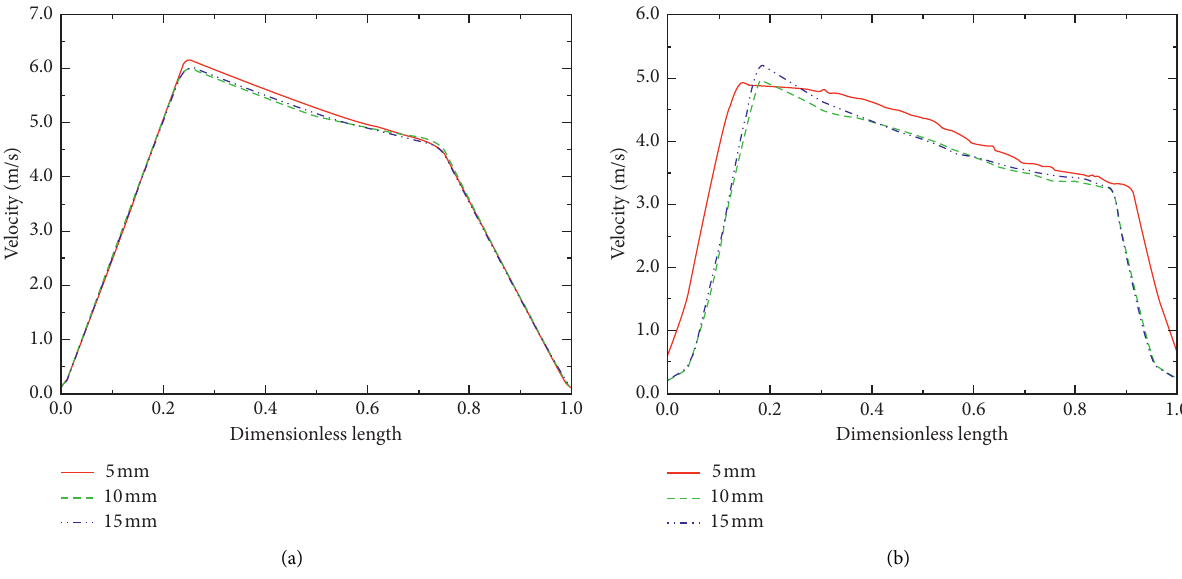
Figure 18: Velocity curves in the guide vane: (a) from the inlet to the outlet and (b) from the front shroud to the rear shroud.